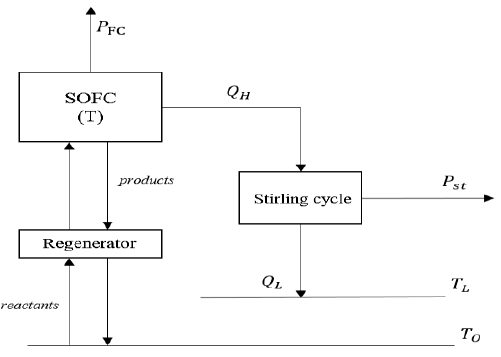
Figure 3. System loop of the hybrid SOFC-SE system as given in Emin [20].